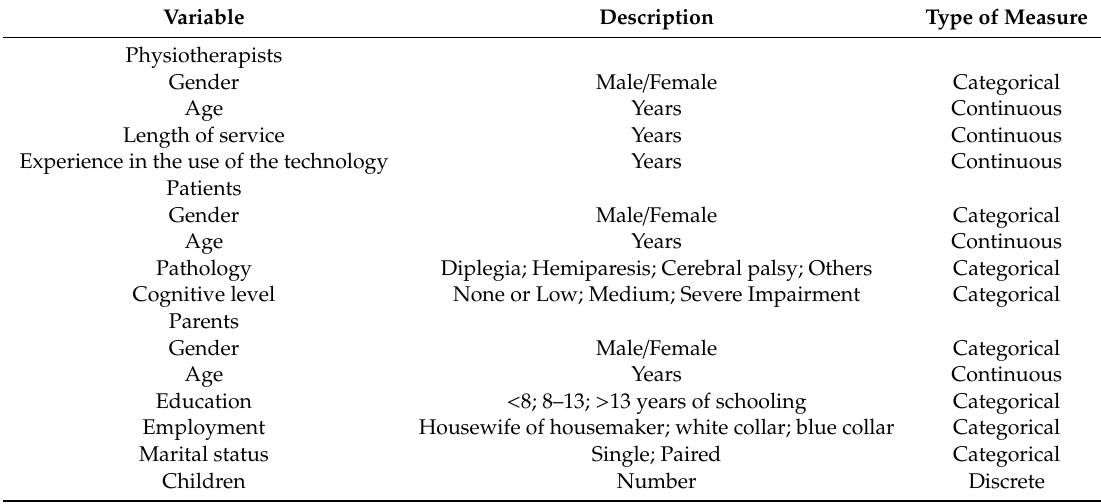
Table 2. Socio-demographic variables considered in the